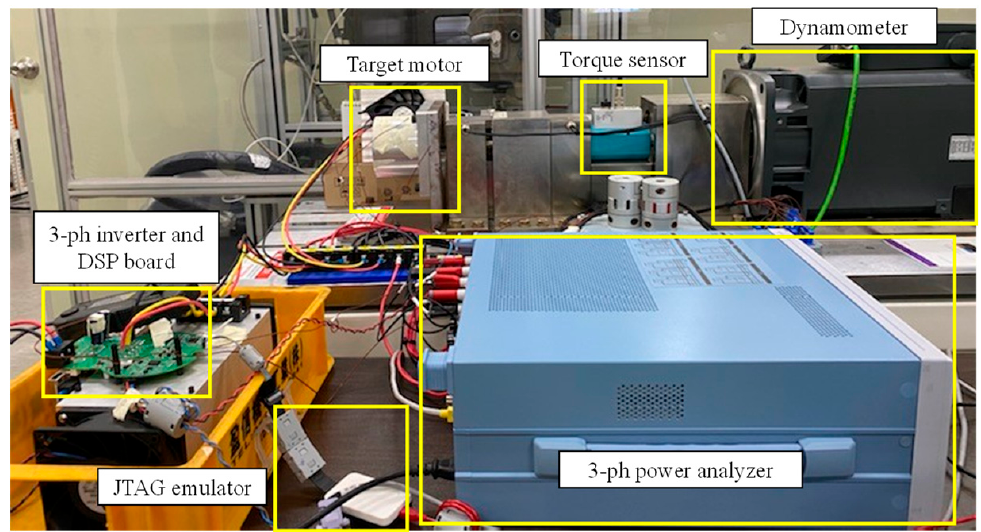
Figure 14. The experimental testbed for no-load and under-load tests.